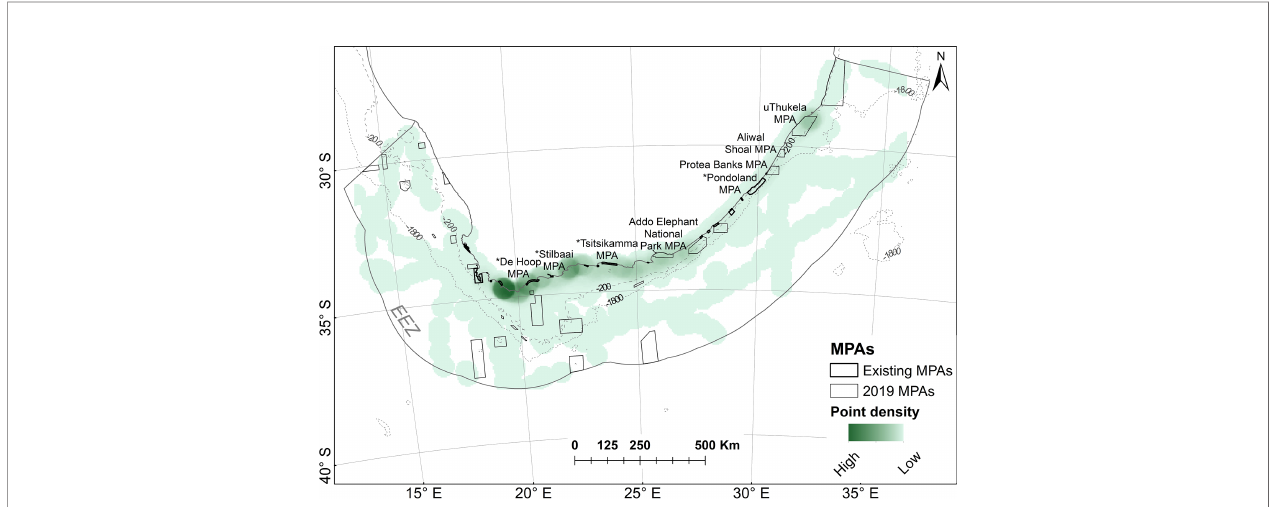
FIGURE 9 | Point densities of white sharks in relation to marine protected areas (MPAs). MPAs in existence during tracking are referred to as “ existing ” MPAs and are indicated with a * in Figure 10 ; others were proclaimed in